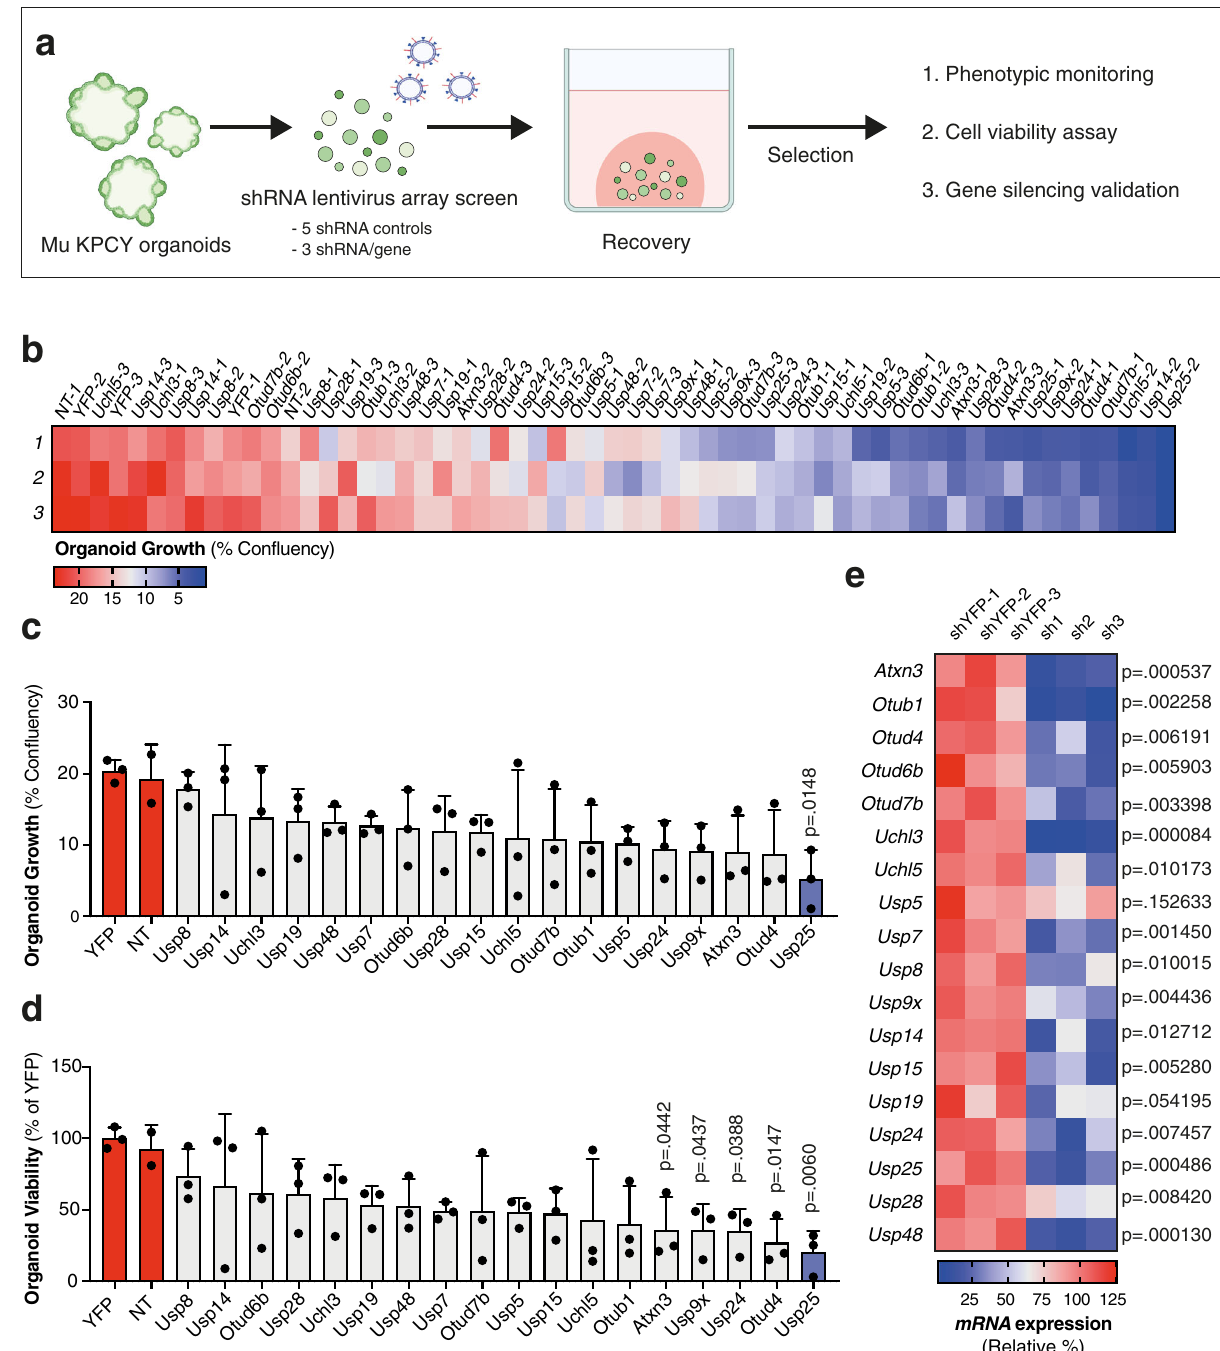
Fig. 2 Genetic knock-down screen identi fi es USP25 as an essential DUB in PDAC organoids. a Schematic of genetic knock-down screen in KPCY organoids, created with BioRender.com. b Heatmap of percentage whole well growth con fl uency (% con fl uency) as measured by a high-content imaging system, 78 h post-puromycin selection. Biological replicates are shown for each individual shRNA target. c Organoid growth shown as % con fl uency, displayed as mean ± standard deviation (SD). Individual shRNA (black circles) values are shown for each gene, averaged from three biological replicates. Statistical signi fi cance was determined by One-way ANOVA with Dunnett post-hoc test ( n = 3 biologically independent samples). d Organoid viability displayed as % relative to control shYFPs (red bars), displayed as mean ± SD. Individual shRNAs (black circles) are shown for each gene, averaged from three biological replicates. Statistical signi fi cance was determined by One-way ANOVA with Dunnett post-hoc test ( n = 3 biologically independent samples). e Heatmap of mRNA expression by qPCR for each individual shRNA per gene, relative to the average of three independent shYFPs. Statistical signi fi cance was determined by two-tailed Student ’ s t test with Holm – Sidak post-hoc correction for multiple testing ( n = 3 biologically independent samples). Source data are provided as a Source Date fi